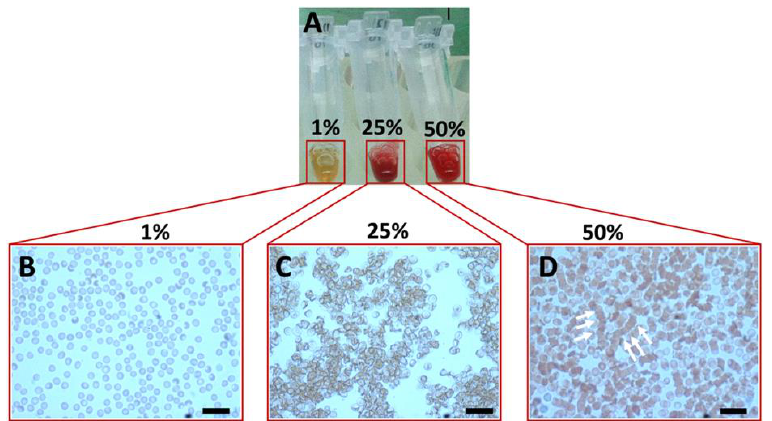
Figure 4. Macroscopic observation of a mixture containing 3-min plasma-treated NAC and 1%, 25%, and 50% of blood ( A ). The representative microscopic images of blood cells from the samples containing 3-min plasma-treated NAC solutions with 1% ( B ), 25% ( C ), and 50% ( D ) of blood. Scale bars represent 20 µm. White arrows indicate rouleaux formation.